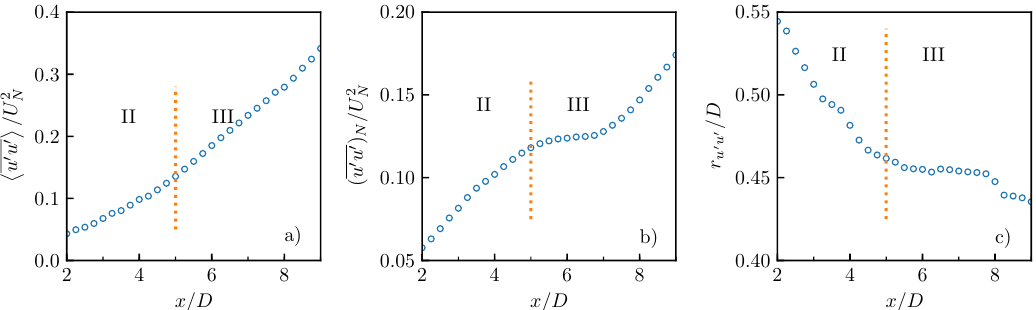
Figure 11. The streamwise development of the characteristic scales of the Reynolds stress component u (cid:48) u (cid:48) . The spanwise averaging u (cid:48) u (cid:48) is shown in ( a ). The characteristic Reynolds stress ( u (cid:48) v (cid:48) ) N is shown in ( b ). In ( a , b ), the Reynolds stress is normalized by the characteristic velocity deficit (cid:68) (cid:69) The characteristic width r u is shown in ( c ). The dotted lines denote the boundary of the stage II and (cid:48) u (cid:48) III of the wake